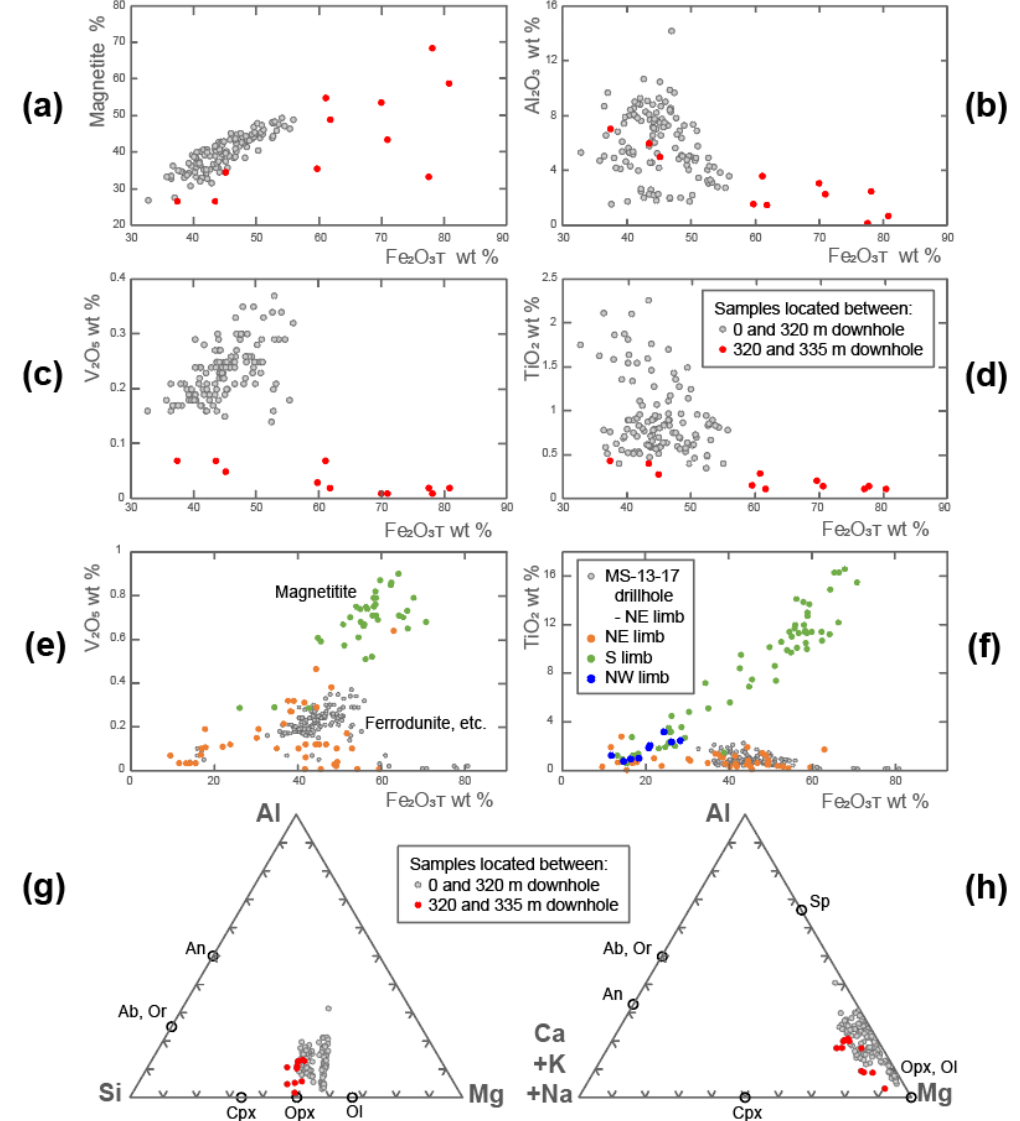
Figure 9. Binary diagrams displaying whole rock analyses ( a , b , c , d , g , h ) from the company dataset (n = 159 minus 7 mafic dyke samples) and ( e , f ) from a literature review performed by Allard [1]. Analyses of the company dataset are separated into two groups because samples located between 320 and 335 m along-hole (i.e., magnetitite unit) have distinct chemistries. The ternary diagrams display elements (molar) controlled by silicates and pleonaste. The data compiled by Allard [1] are whole rock analyses of gabbro, pyroxenite, magnetitite, and ferrodunite.